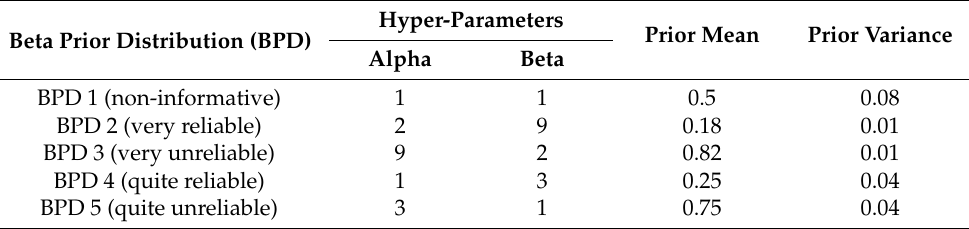
Table 2. Parameters of the adopted beta prior